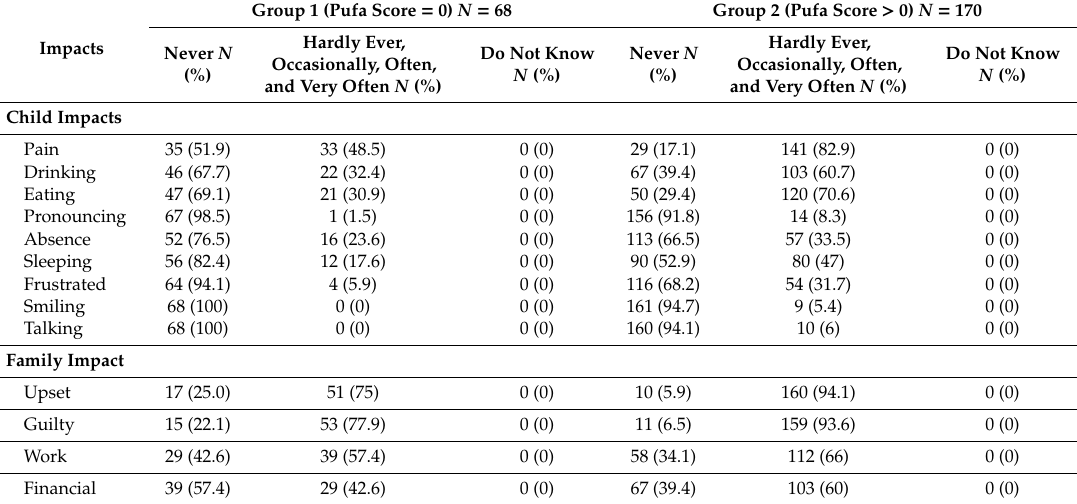
Table 3. Distribution of Early Childhood Oral Health Impact Scale (ECOHIS) responses for the subgroups, divided based on the pufa index score-group 1 (pufa score = 0), N = 68, and group 2 (pufa score > 0), N = 170.